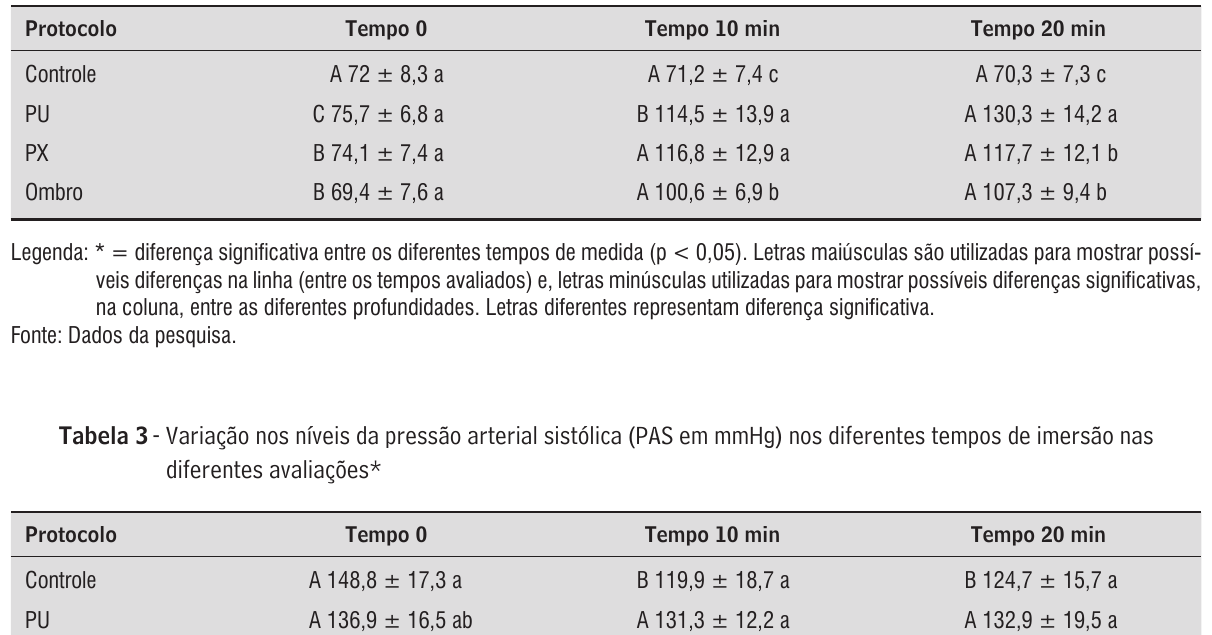
Tabela 2 - Dados em termos de média ± desvio-padrão da frequência cardíaca (FC-bat/min) nos diferentes tempos